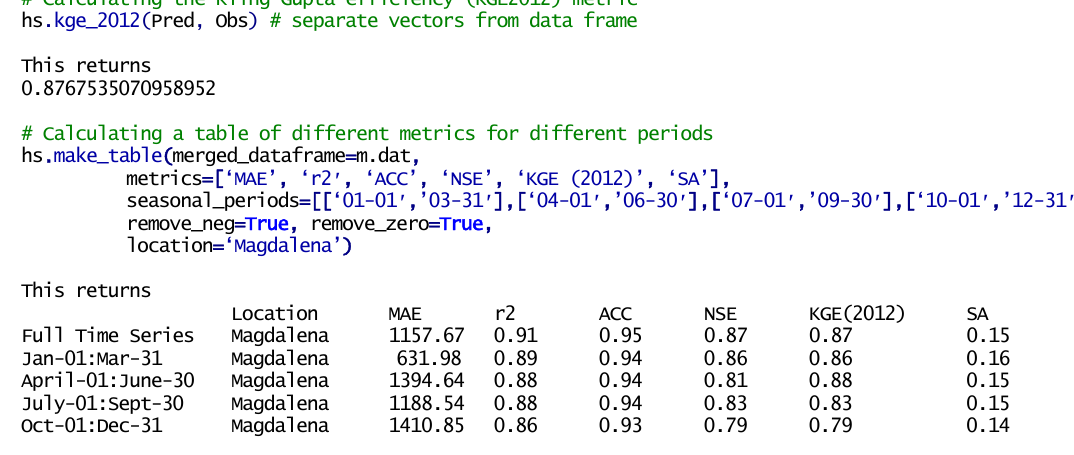
Figure 4. Presents a code example and results of calling a single error metric (top portion) and creating a table with six different error metrics over four different seasons or time periods. This shows that while the metric values are similar, the different seasons behave differently.